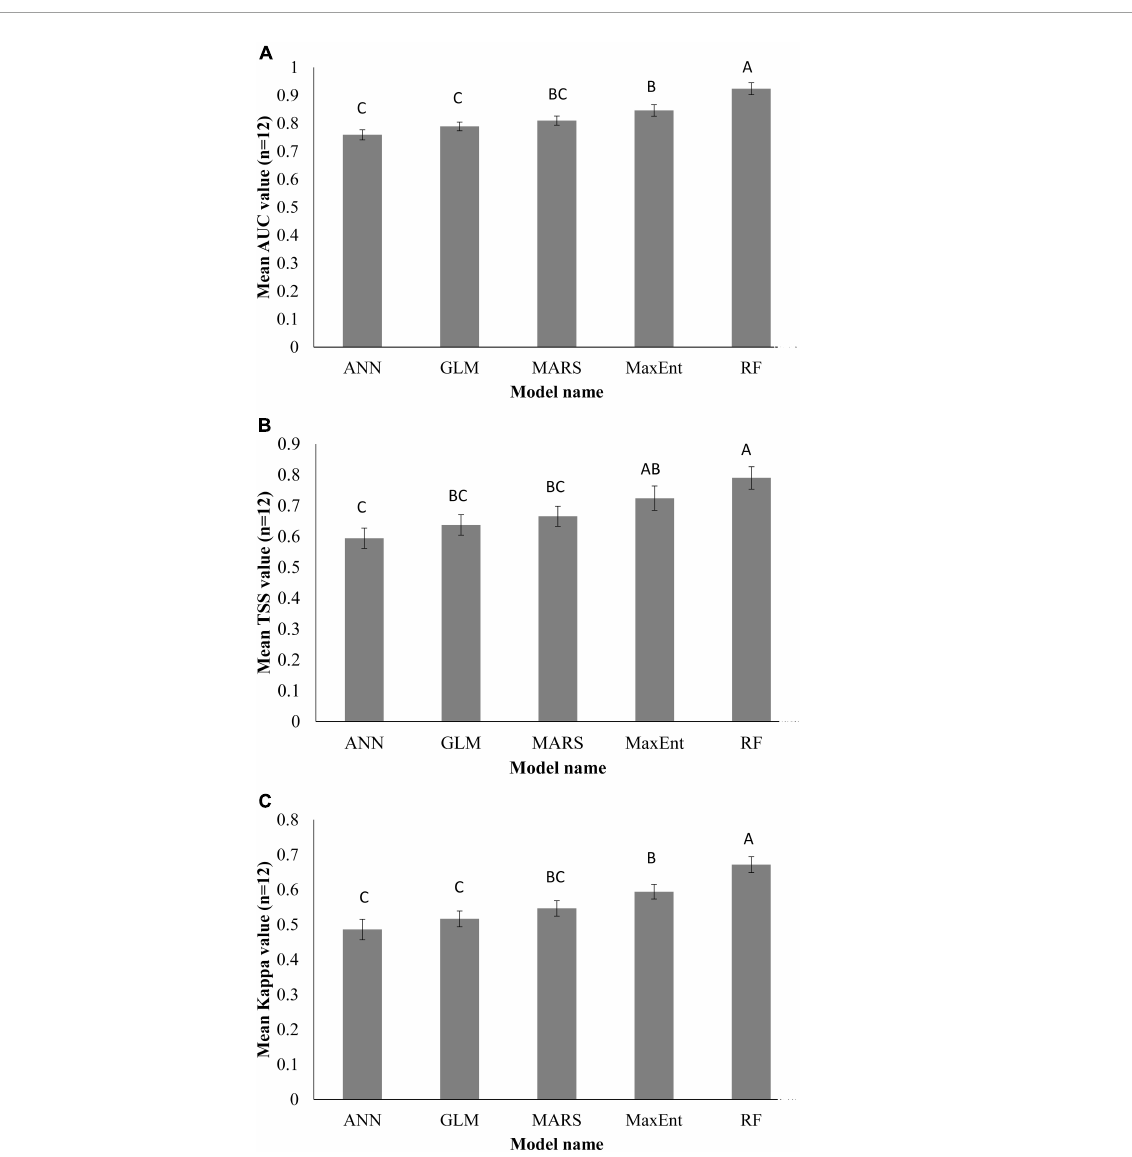
( Table 4 ). The average distribution area of 12